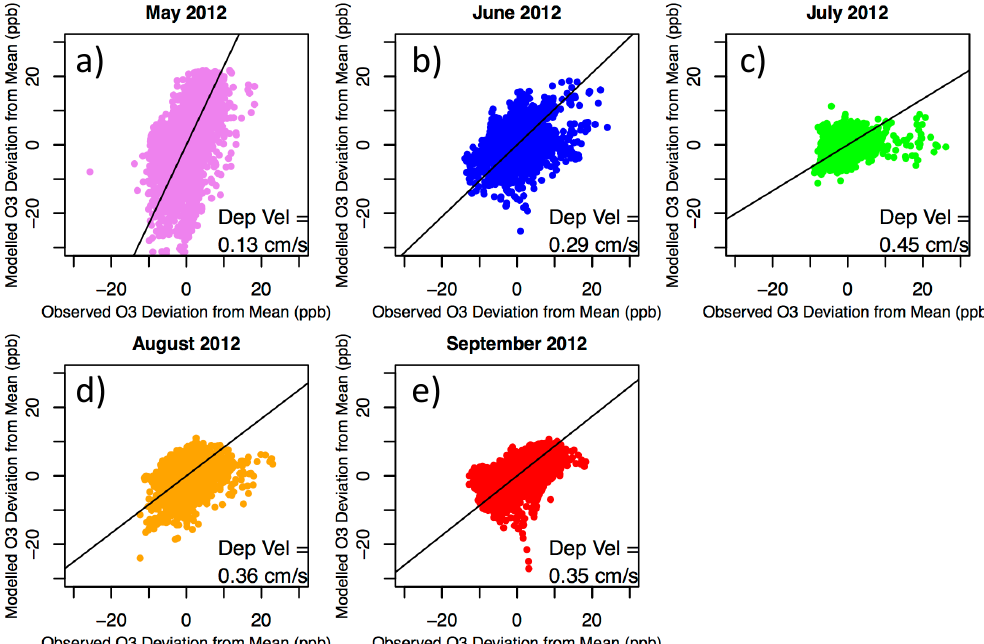
Figure 19. Deviation of modeled and measured ozone concentrations (ppb) from the means of each flight for each month of the 2012 campaign ( a – e ). Computed deposition velocity (cms − 1 ) is shown in the lower right corner of each